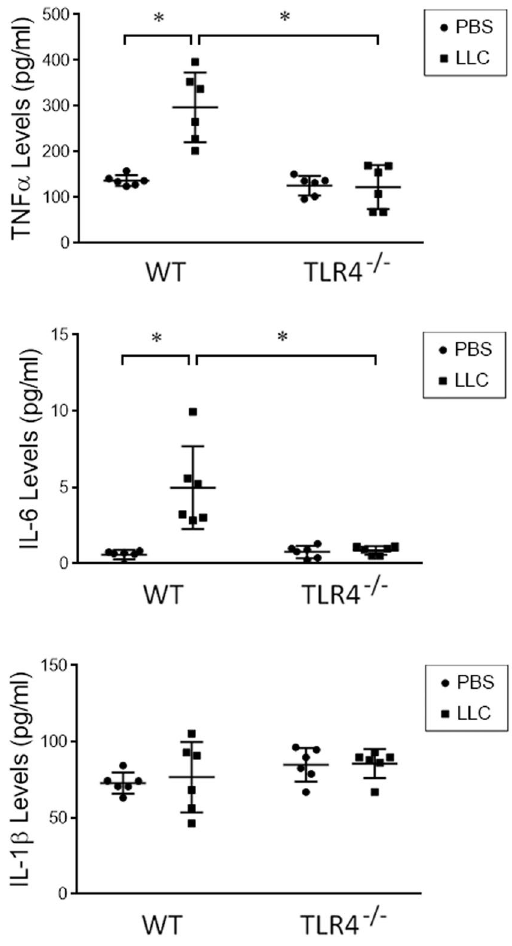
Figure 5. TLR4 is required for LLC tumor-induced elevation of circulating catabolic cytokines in mice. Sera collected from mice described in Fig. 3 on day 21 of LLC tumor implant were analyzed for catabolic cytokines TNF α , IL-6 and IL-1 β by multiplex immunoassay (Bio-Rad). Data was analyzed by ANOVA. * Denotes a difference ( P <